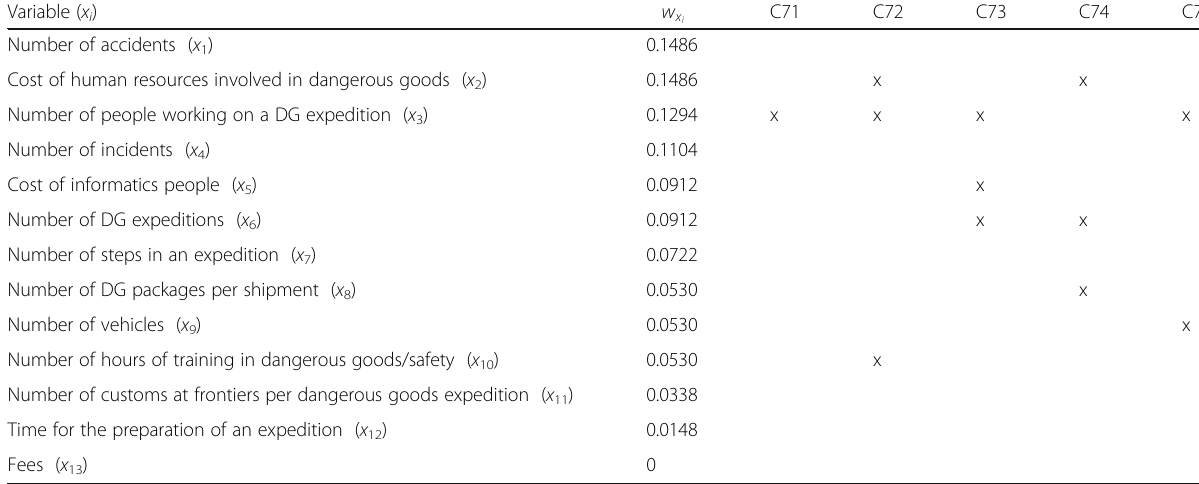
Table 6 Dependences between quantifiable barriers c j and variables x i , and weights of x i by BN Variable ( x i